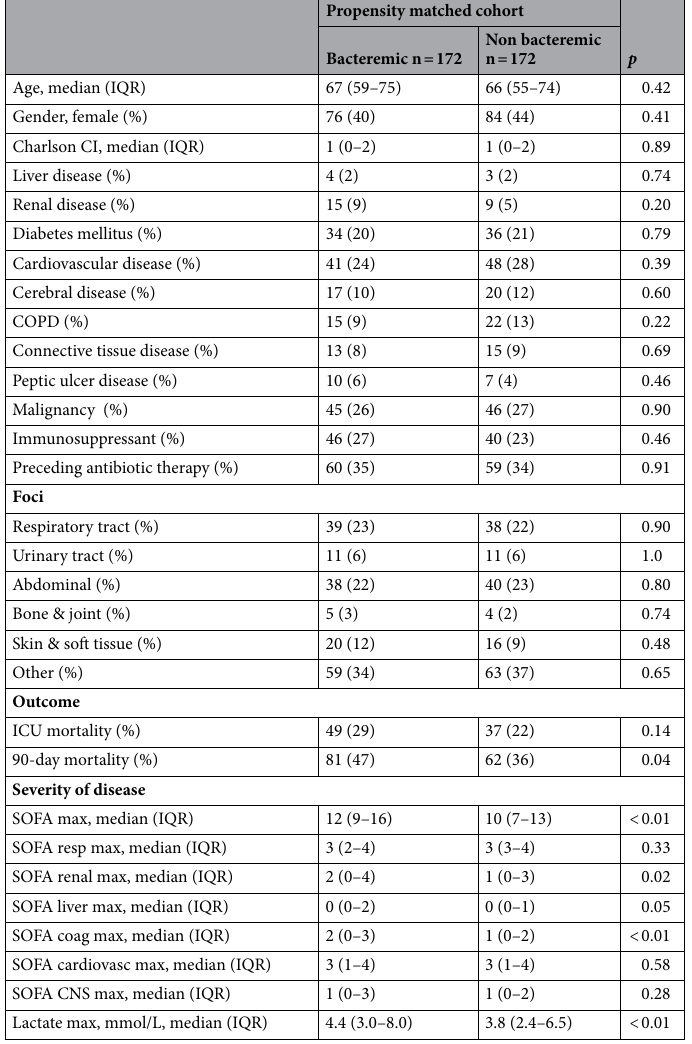
Table 3. Demography and morbidity of the propensity matched cohort. IQR interquartile range, CI Comorbidity Index, COPD Chronic Obstructive Pulmonary Disease, SOFA Sequential Organ Failure Assessment, CNS Central Nervous System.